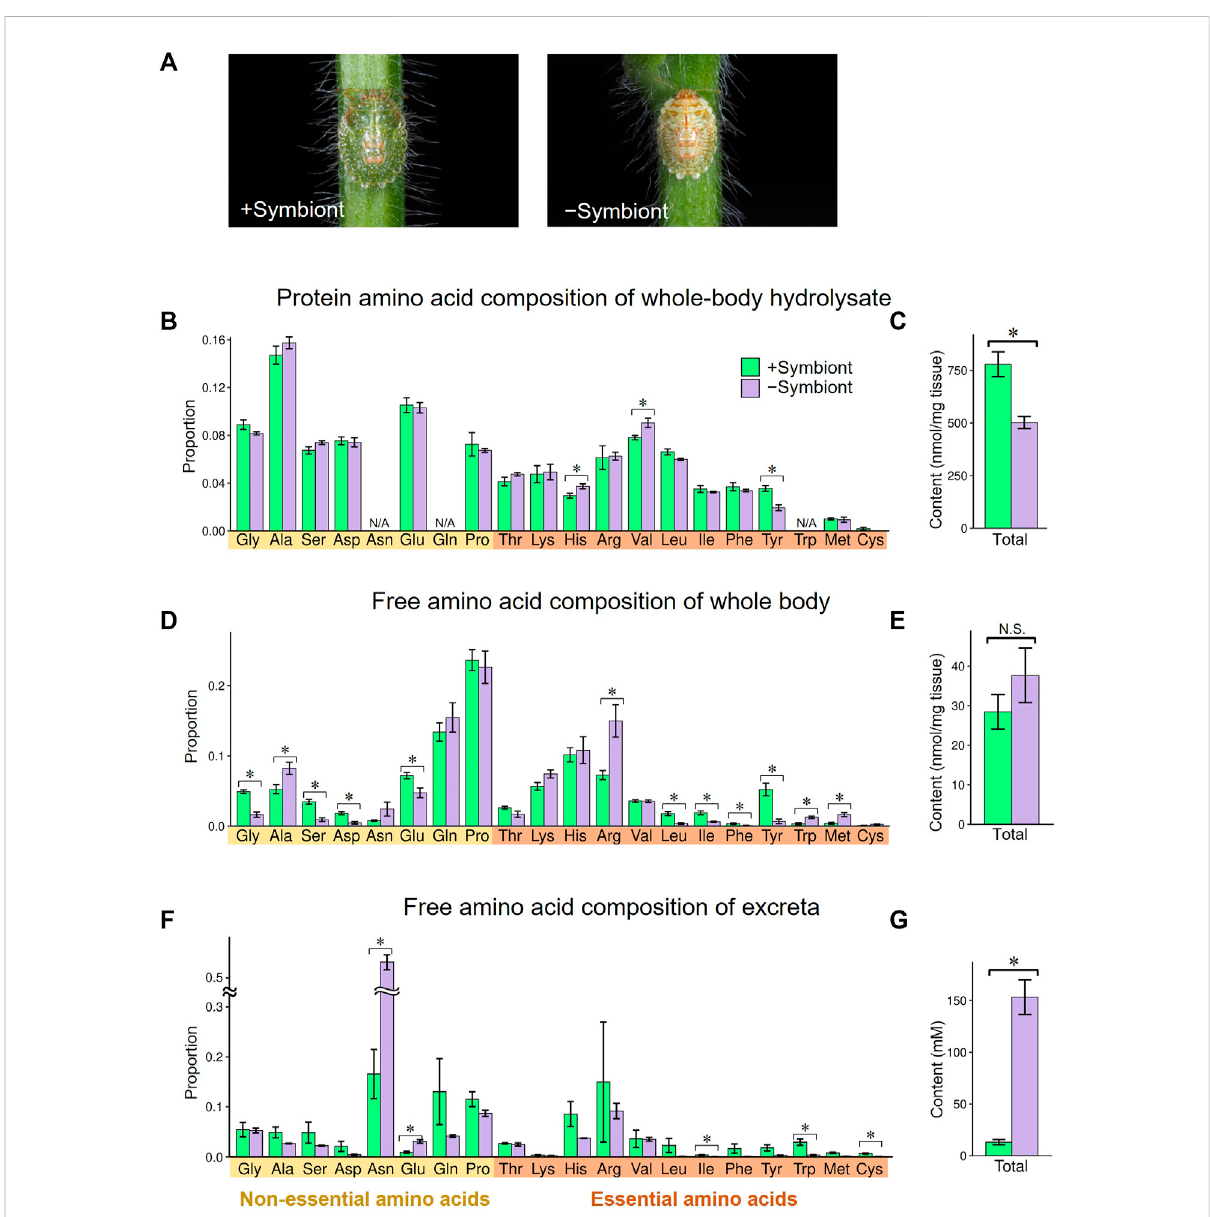
FIGURE 4 Effects of symbiont removal on amino acid pro fi les in fourth instar nymphs of M. punctatissima . (A) External appearance of symbiotic (left) and aposymbiotic (right) fourth instar nymphs. (B,C) Protein amino acids from the whole body. (D,E) Free amino acids from the whole body. (F,G) Free amino acids in the excreta. (B,D,F) Relative proportion of each amino acid. (C,E,G) Total amount of amino acids. For (B) , the amounts of asparagine and glutamine were incorporated into aspartate and glutamate, respectively, while that of tryptophan was omitted (N/A) due to the hydrolysis treatment. Means ± s.e.m are shown ( N = 6 for (B – E) , N = 3 for (F,G) ). Asterisks indicate statistically signi fi cant differences ( p < 0.05, t